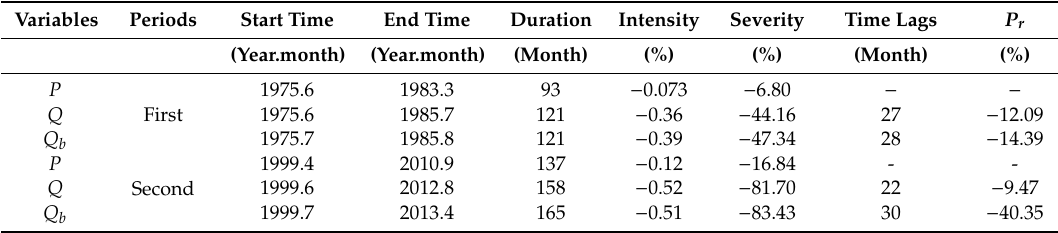
Table 2. Meteorological (precipitation, P ) and hydrological (streamflow, Q ; baseflow, Q b ) characteristics of the Taoer River basin, the start and end times, duration, intensity, severity, time lags, and the precipitation recovery rate ( P r , calculated as the ratio of the accumulated relative precipitation anomaly between the end of meteorological drought and the end of hydrological drought over the time lag, % per month).